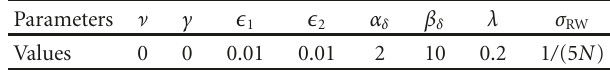
Table 2: Parameters of the